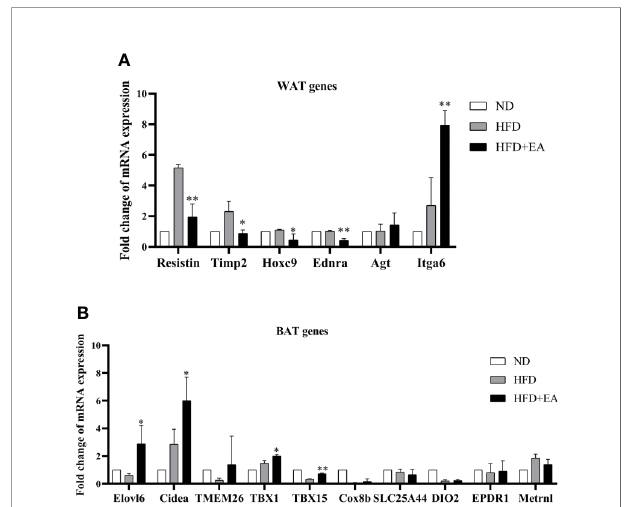
FIGURE 3 | EA treatment induced the mRNA expression of WAT and BAT related genes in IWAT. Fold change of WAT (A) and BAT (B) relating genes mRNA expressions. Data were represented as mean ± SD (n = 3). *P < 0.05, **P < 0.01 vs. the HFD+ EA